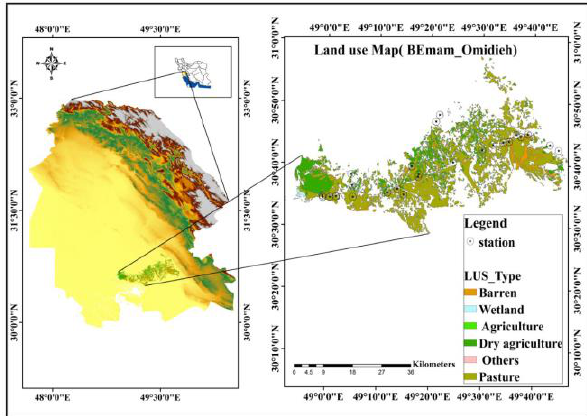
Figure 1: Study area along with various land covers found in Bandar-e Emam-Omidieh,